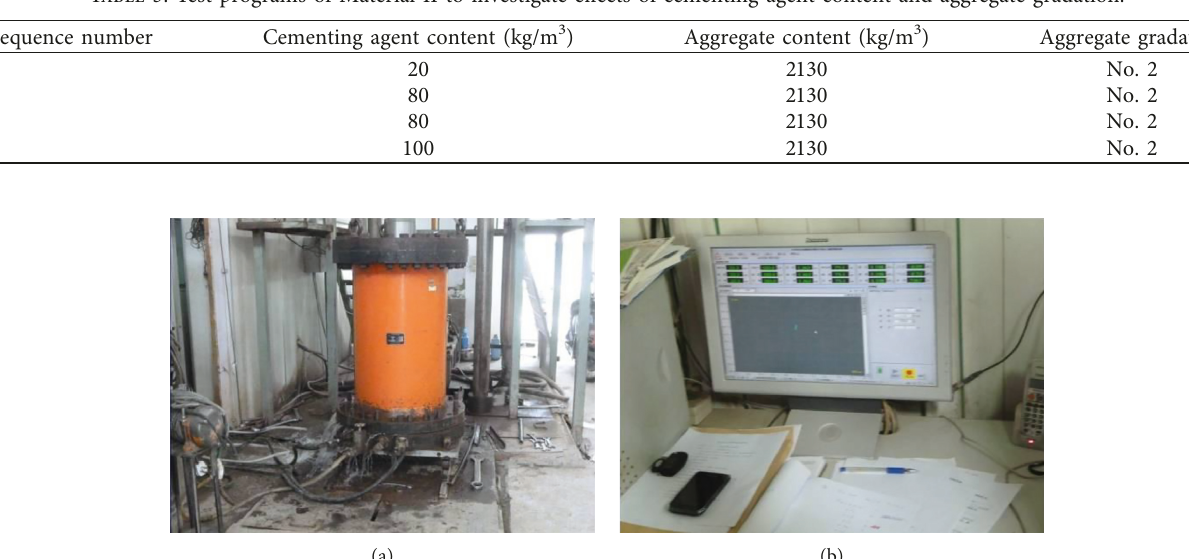
Figure 1: TYD-1500 triaxial tester, which should be listed as (a) large-scale dynamic triaxial tester; (b) data acquisition system.